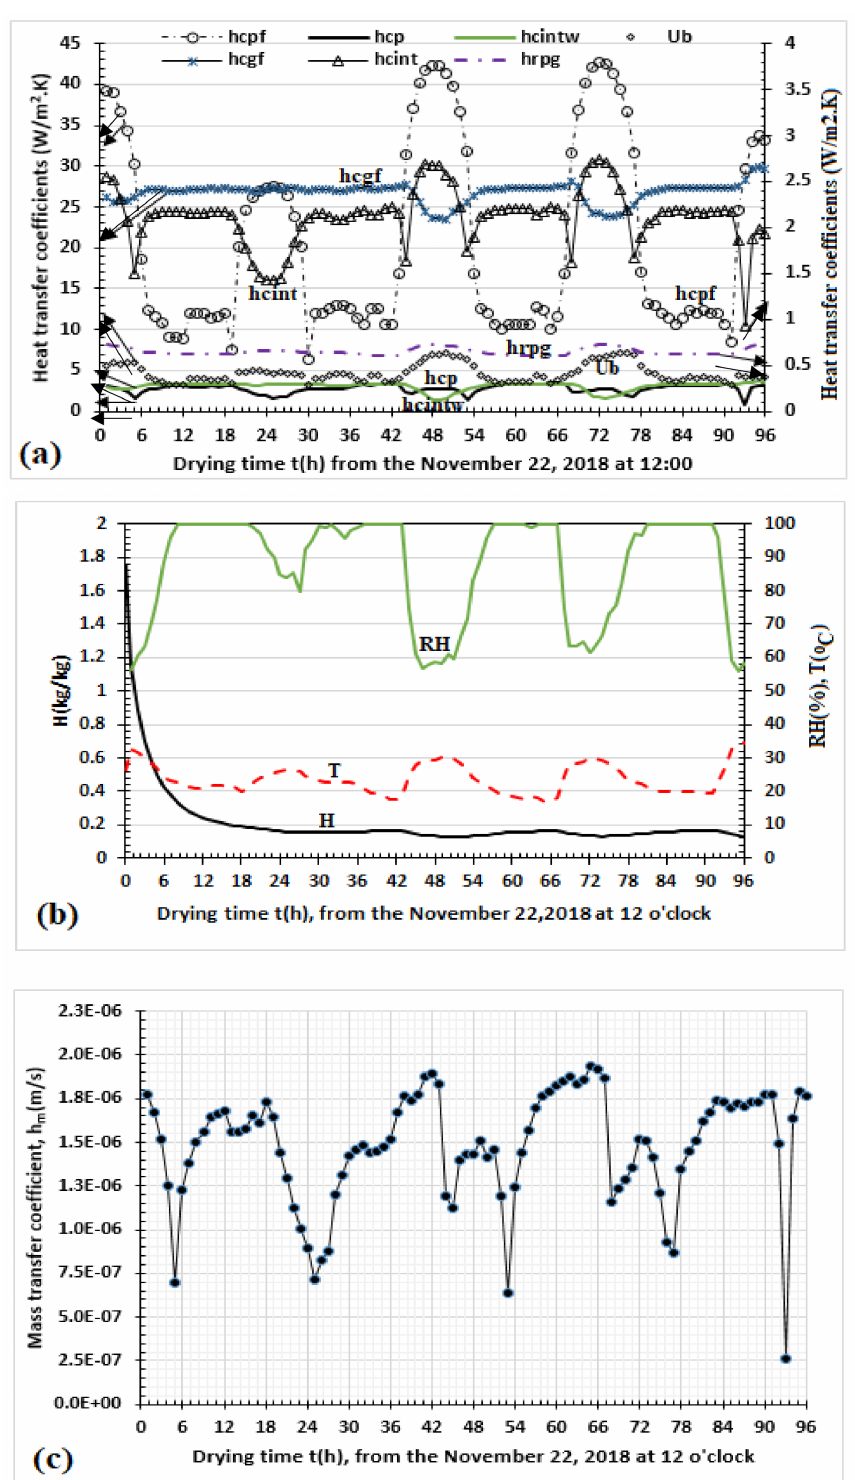
Figure 8. Drying kinetics in Yaound é (Cameroon) from 22 November 2018, at noon (design 2). Heat transfer coefficients ( a ), Temperature, relative humidity and moisture content variations ( b ), mass transfer coefficient ( c